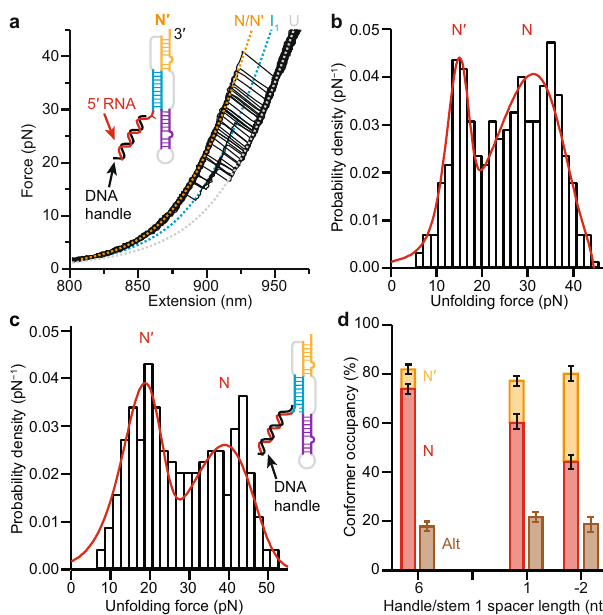
Fig. 3 Occlusion of 5 ′ end suppresses folding of threaded conformer. a Unfolding FECs measured with 1-nt spacer between duplex handle and pseudoknot show same length changes as in Fig. 2. Dashed lines show WLC fi ts. Inset: schematic showing location of handle duplex. b Unfolding force distribution with 1-nt spacer between handle and pseudoknot ( N = 342 FECs from 8 molecules) shows more prominent low-force peak and less prominent high-force peak. c Re-measuring unfolding with handle extending 2 nt into stem 1 of pseudoknot (inset: schematic showing location of handle duplex) yields unfolding force distribution ( N = 220 FECs from 3 molecules) with even more prominent low-force peak and even less prominent high-force peak. d Fraction of FECs showing higher-force pseudoknot unfolding (red) decreases systematically as duplex handle is extended towards stem 1 of pseudoknot (or invades it), with compensating increase in fraction showing lower-force pseudoknot unfolding (orange), whereas fraction showing alternative stem-loop unfolding (brown) remains constant. Error bars on occupancies of pseudoknotted (sum of N and N ′ ) and alternate conformers (Alt) represent standard error of proportion from numbers of FECs showing each conformation type; error bars on fraction of pseudoknotted conformers occupying N/N ′ represent fi tting errors from analysis of unfolding force distributions with two-population landscape model (errors correlated for N and N ′ , as shown). N = 1825 FECs from 10 molecules for 6-nt spacer, 491 FECs from 8 molecules for 1-nt spacer, and 270 FECs from 3 molecules for − 2-nt